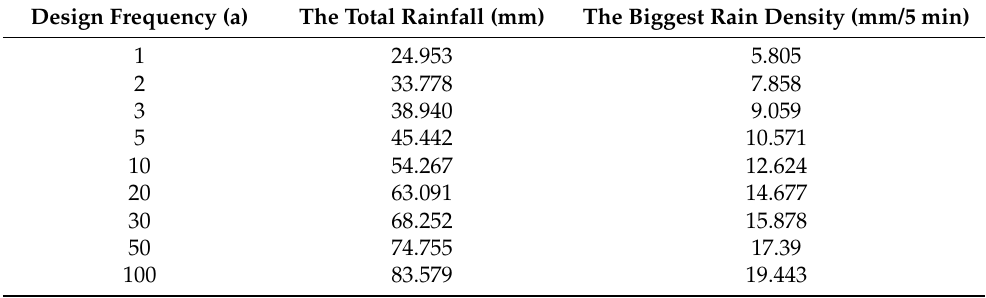
Table 1. Designed rainstorm parameters.